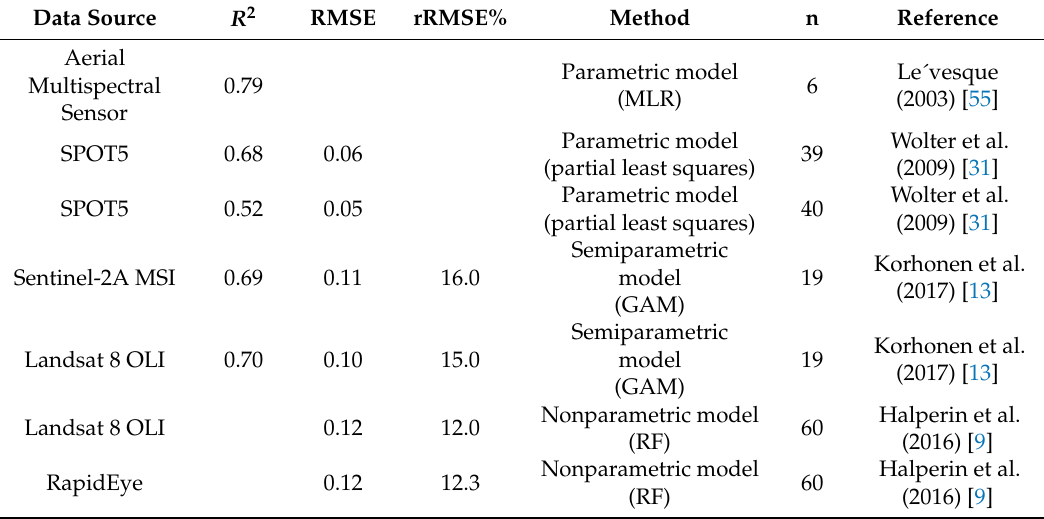
Table 5. Comparison of GF-1 estimation of canopy closure (CC) and other